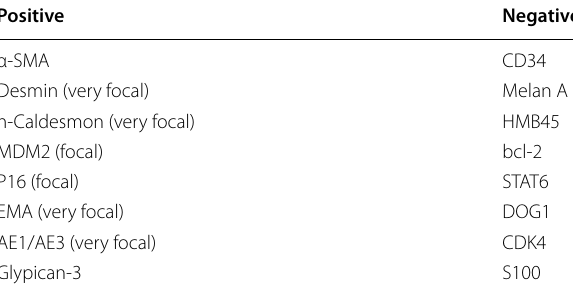
Table 1 Immunohistochemical